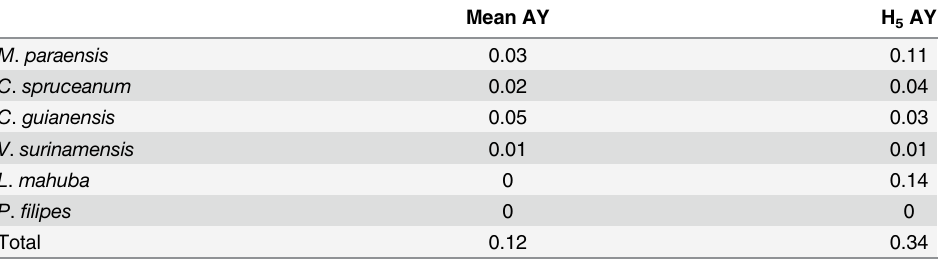
Table 5. Differences in annualized yields (m 3 yr -1 ha -1 ) between species-specific and general optimal management regimes under two STM